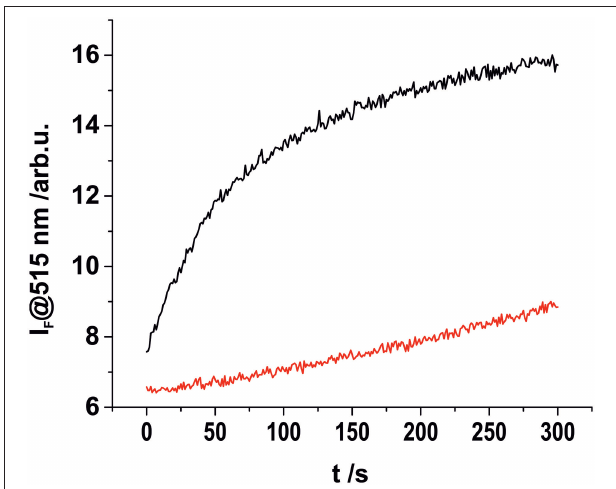
FIGURE 3 | Kinetic investigation of complex 1 in acetonitrile (2 × 10 − 8 M) upon addition of 1.5 eq., of aqueous HS − solution (black), and in the absence of an analyte